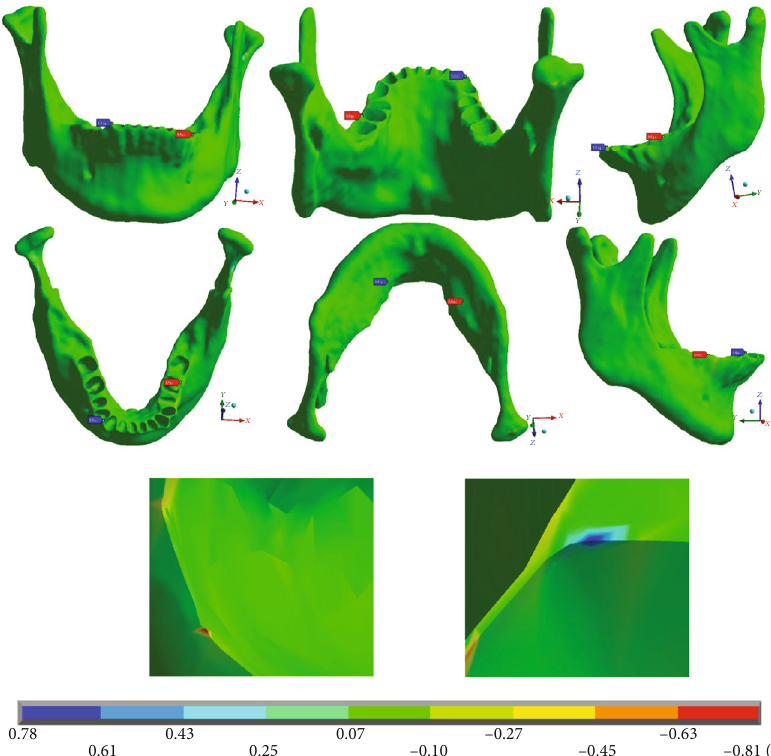
Figure 17: Normal stresses in Y , mandibular bone. The red marker indicates the maximum stresses, and the blue marker indicates the minor stresses.